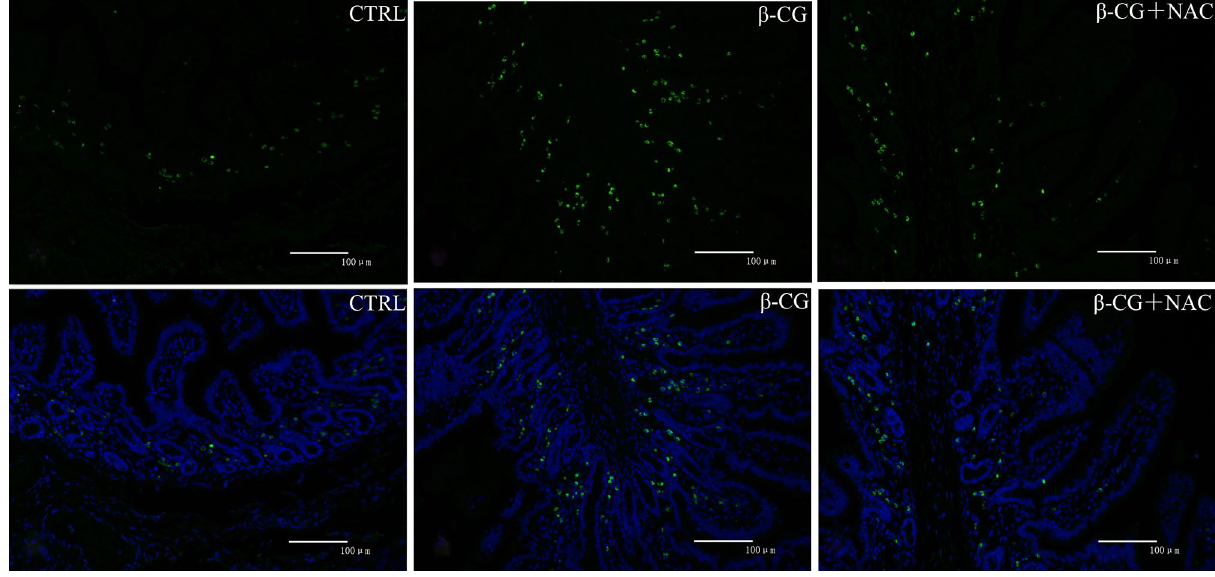
Figure 5. Apoptotic changes in the jejunal mucosa as assessed by the TUNEL method. Paraffin sections of the jejunum were double stained for TUNEL (green) and DAPI (blue) assays. β-CG induced an increase in enterocyte apoptosis in the jejunum of piglets, and this effect of β-CG was alleviated by NAC treatment (× 200).